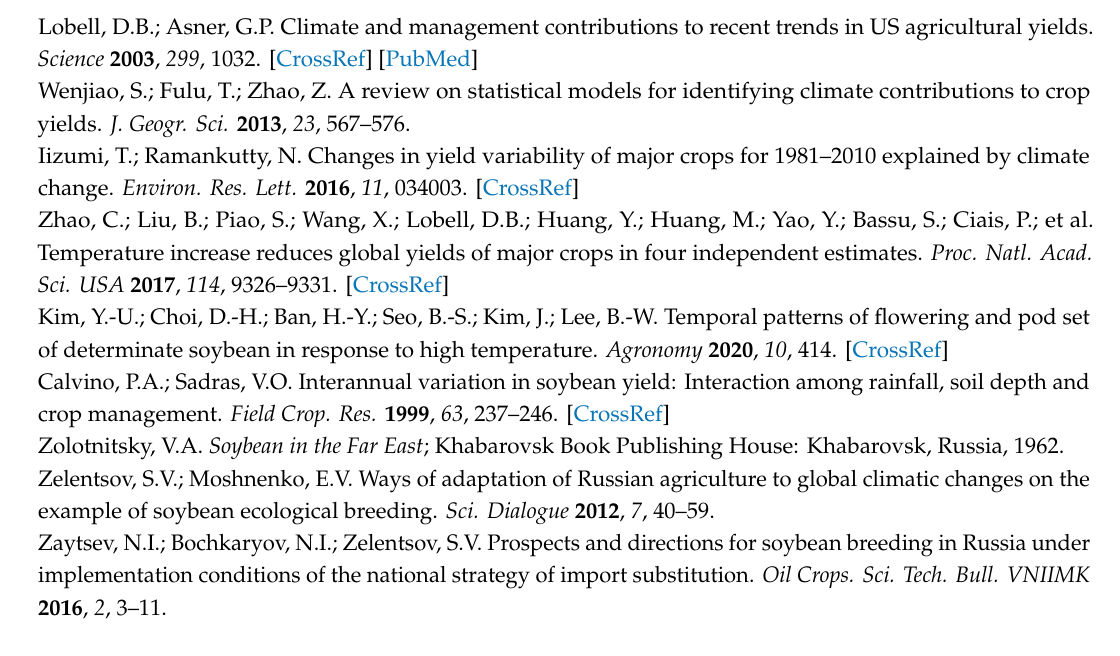
Table S1. Characteristics of 424 soybean accessions in conditions of Krasnodar and Primorye Territories of Russia. Table S2. The characteristics of standard varieties in Krasnodar and Primorye Territories of